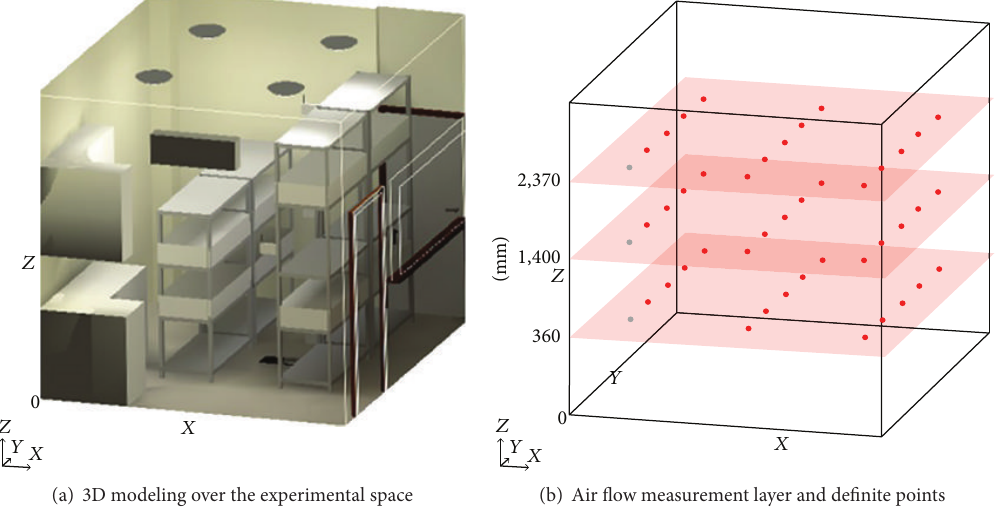
Figure 2: Standards for air flow distribution measurement.